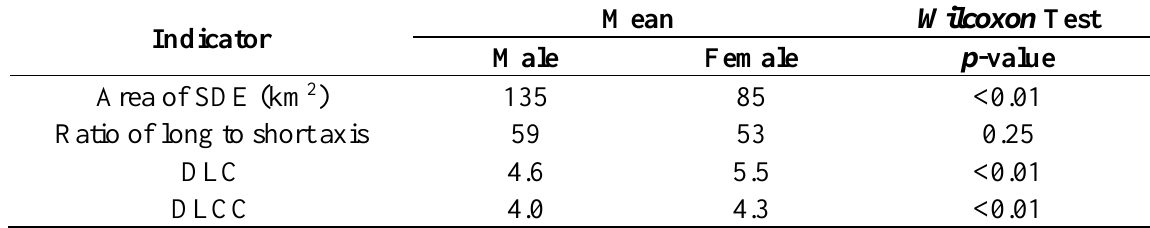
Table 2. Average area of SDE , ratio of long to short axis, DLC and DLCC values for male and female users and the results of the Wilcoxon